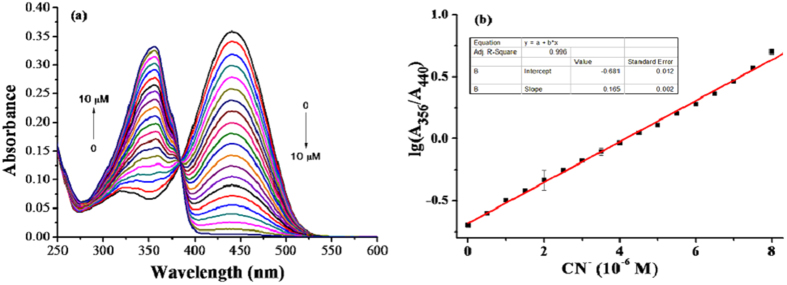
(a) UV-vis absorption titration spectra of SY (5 μM) in the presence of CN− (0–10 μM) in acetonitrile at room temperature; (b) The linear relationship between the logarithm of the absorbance values (A356/A440) and CN− concentration (0–10 μM).